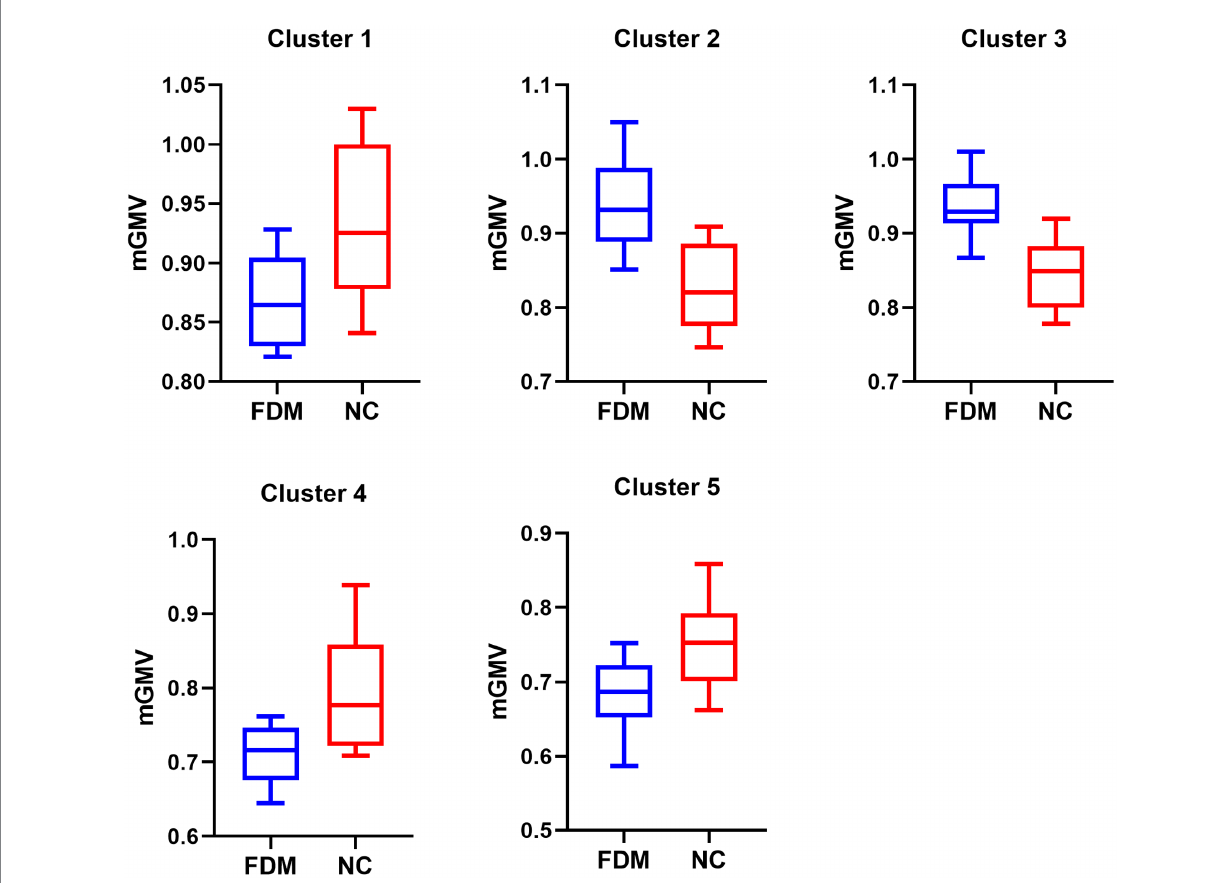
FIGURE 3 The significant GMVs between the FDM group and NC group. The left denotes the FDM group, and the right denotes the NC group in five significantly different clusters. GMV, gray matter volume; FDM, form-deprivation myopia; NC, normal